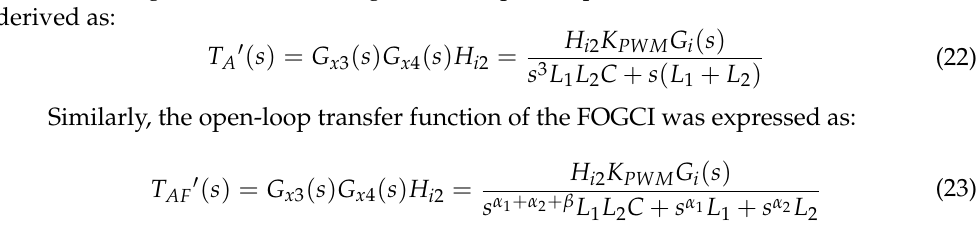
Figure 9. Simplified diagram of the GCI without capacitor current proportional feedback.